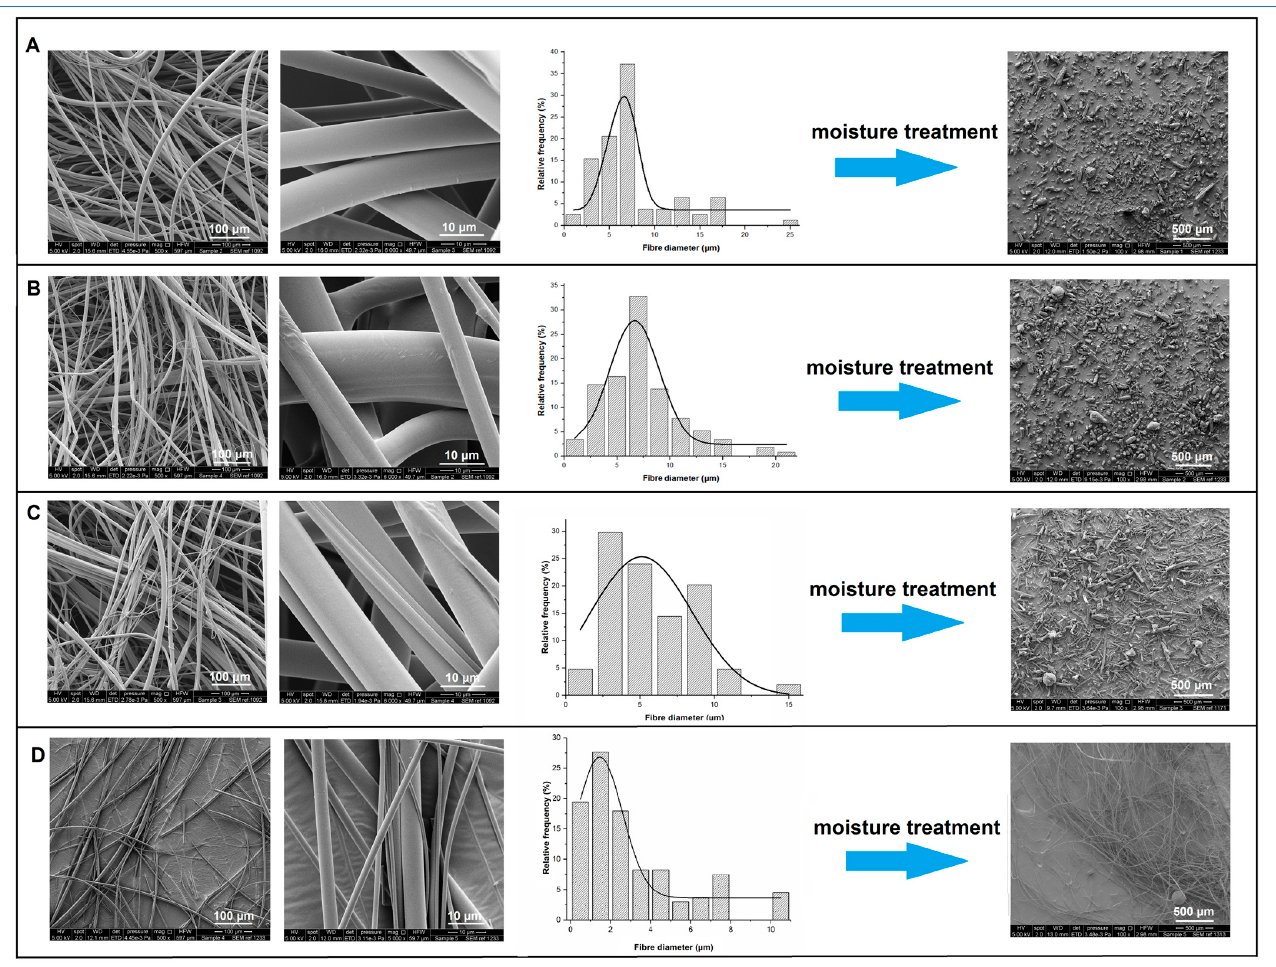
Figure 1. From left to right: SEM micrographs of freshly prepared itraconazole-loaded sucrose microfibres (500× and 6000× magnification), microfibre diameter frequency diagrams, SEM images of the corresponding samples (100× magnification) after 30 days exposure to 25 °C/75%RH. ( A ) 20% w / w , ( B ) 30% w / w , ( C ) 50% w / w itraconazole-loaded sucrose microfibres, and ( D ) 100% w / w itraconazole microfibres.